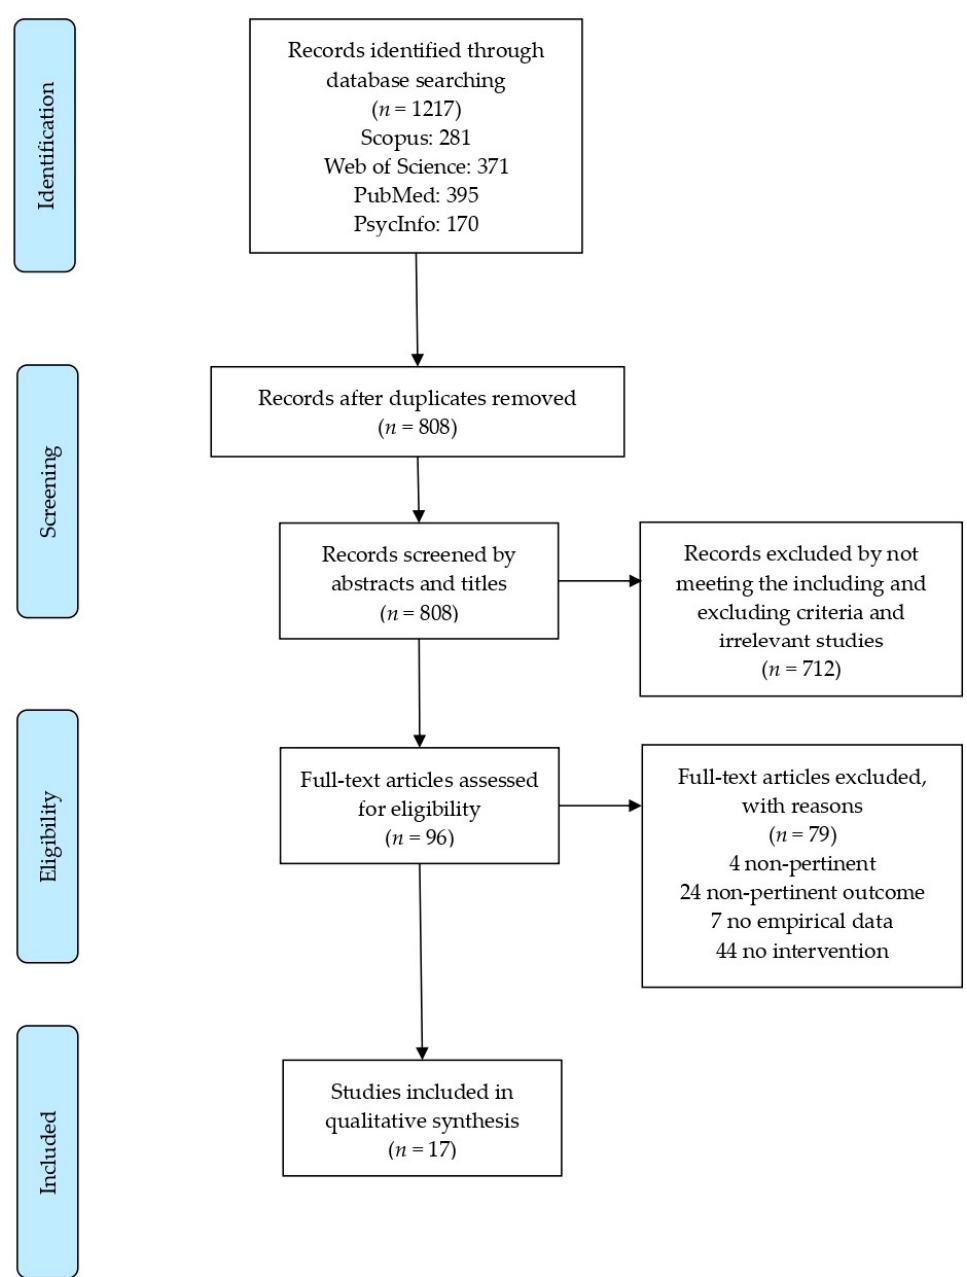
Figure 1. Flow diagram of the search strategy. Modified from the Preferred Reporting Items for Systematic reviews and Meta-Analyses statement flow diagram [32].